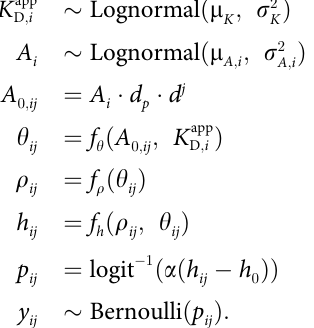
with higher agg